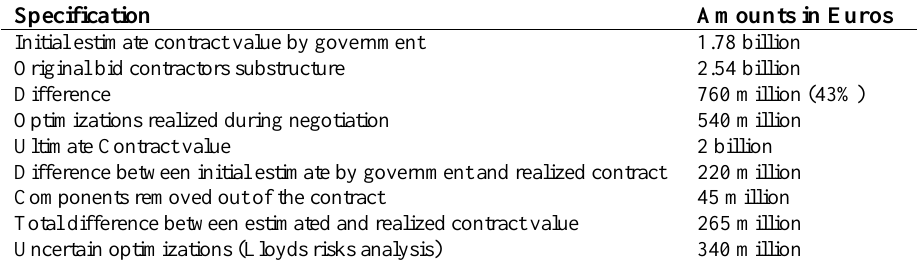
Table 1. Development of contract value during negotiations on the substructure